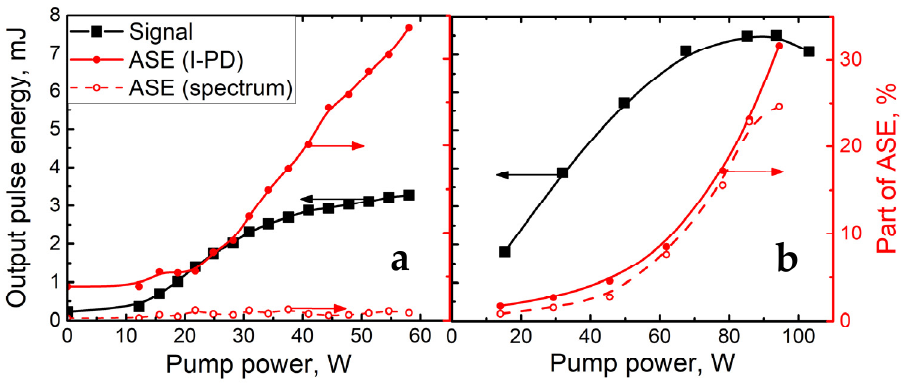
Figure 4. Dependence of the output energy and part of optical power propagated in ASE (measured by two methods) on the pump power, ( a ): T-EDF with cut of thin end up to the outer diameter of 110 μ m; ( b ): Er-doped fiber with constant core/clad diameters of 90/125 μ m.